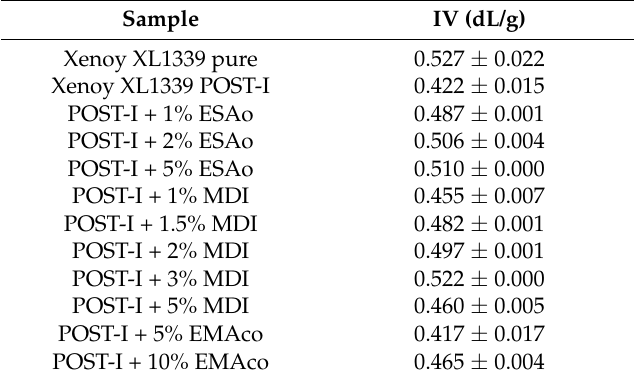
Table 1. Intrinsic viscosity (IV) of the materials, before and after recycling